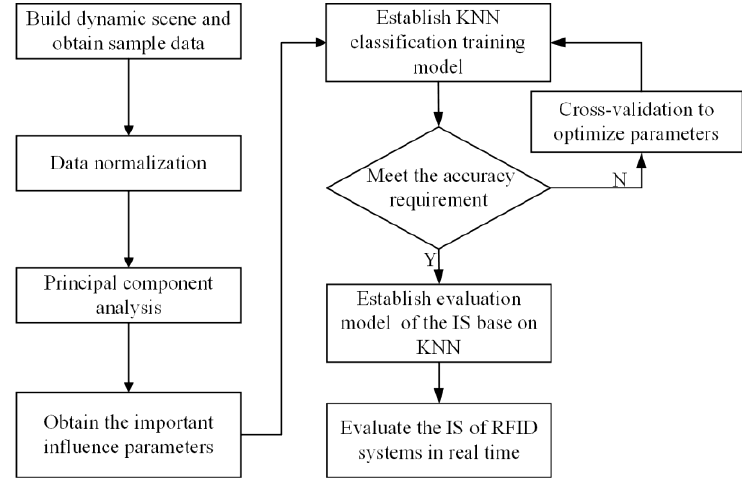
Figure 7. The evaluation model of the IS.